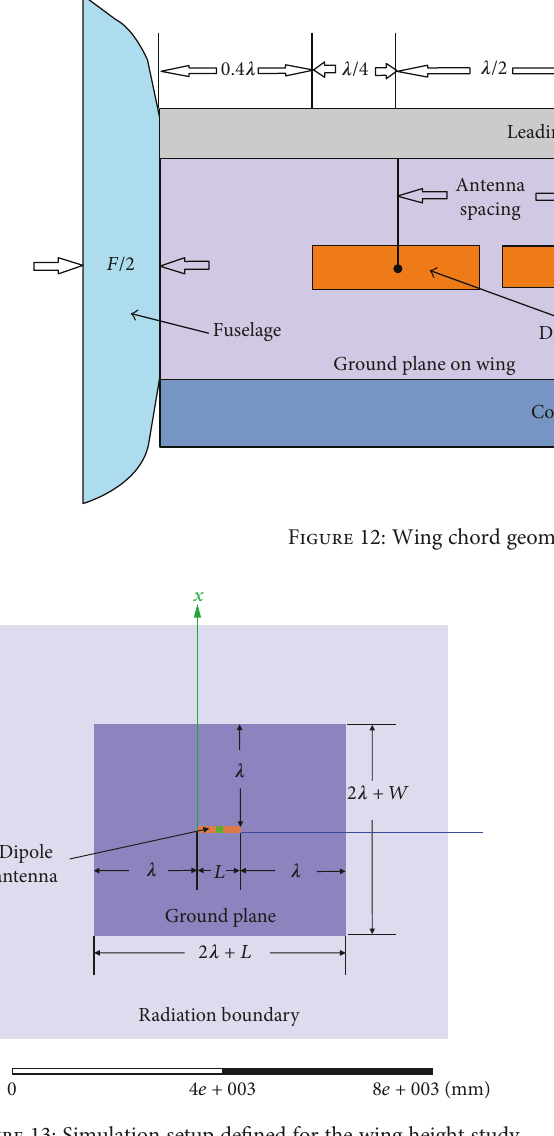
Figure 13: Simulation setup de fi ned for the wing height